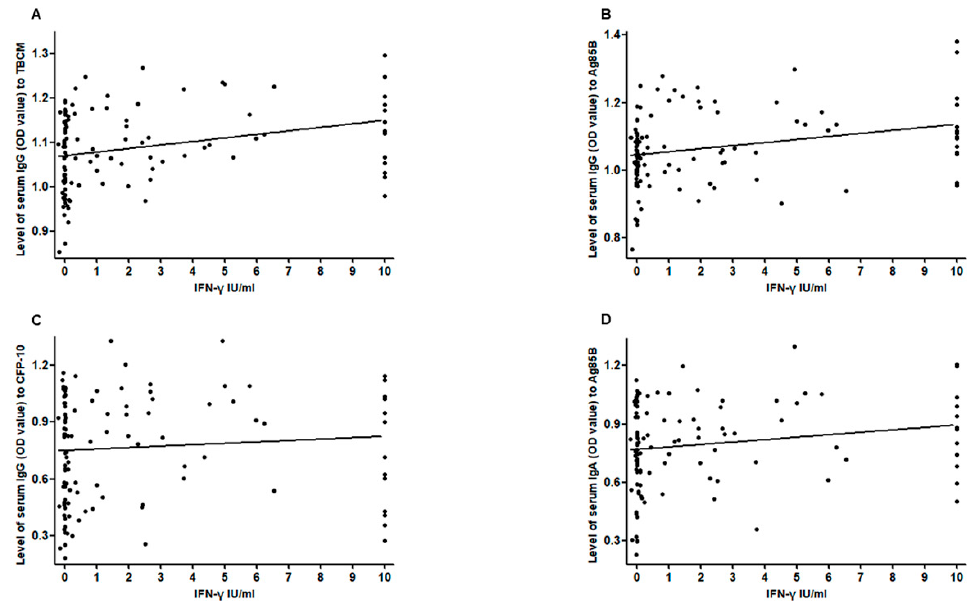
Figure 5. Correlation between the level of interferon-gamma and the level of serum IgG against TBCM ( r = 0.303, p = 0.001) ( A ), IgG against Ag85B ( r = 0.286, p = 0.002) ( B ), IgG against CFP-10 ( r = 0.259, p = 0.005) ( C ), and IgA against Ag85B ( r = 0.193, p = 0.039) ( D ).